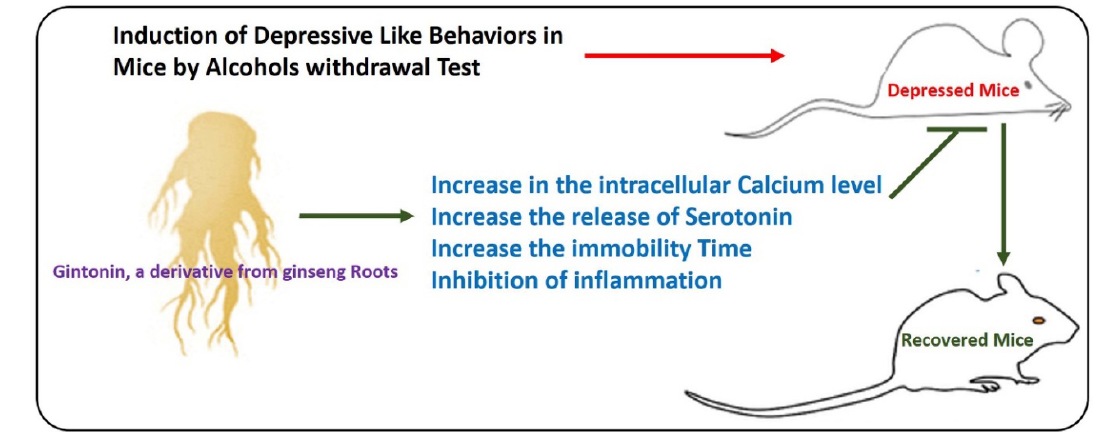
Figure 6. Antidepressant effects of gintonin. A simple illustration showing the protective effects of gintonin against depressive behavior in mice by increasing the intracellular calcium level, increasing the release of serotonin, and increasing the immobility time. Neuroinflammation is the main inducer of depression, but it has not been analyzed in the current studies. Gintonin may counteract depressive symptoms in mice, possibly by regulating the inflammatory mediators, increasing the immobility time, and increasing the release of serotonin and intracellular calcium levels.